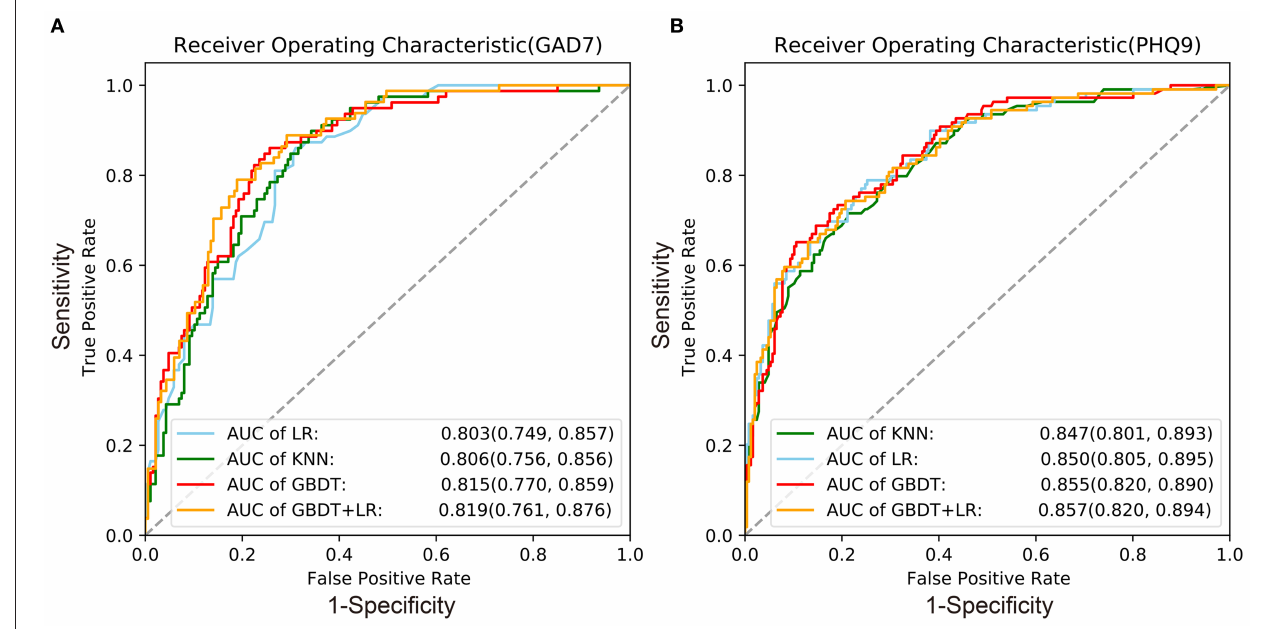
FIGURE 1 | Receiver operating characteristic curves of the four machine learning models. (A) Anxiety (GAD-7); (B) depression (PHQ-9). KNN (k-nearest neighbors); LR (logistic regression); GBDT (gradient-boosted decision tree); GBDT + LR (a combination of GBDT and LR); AUC, area under the curve. 95%CI = (mean − 1.96 * standard deviation, mean + 1.96 * standard deviation).